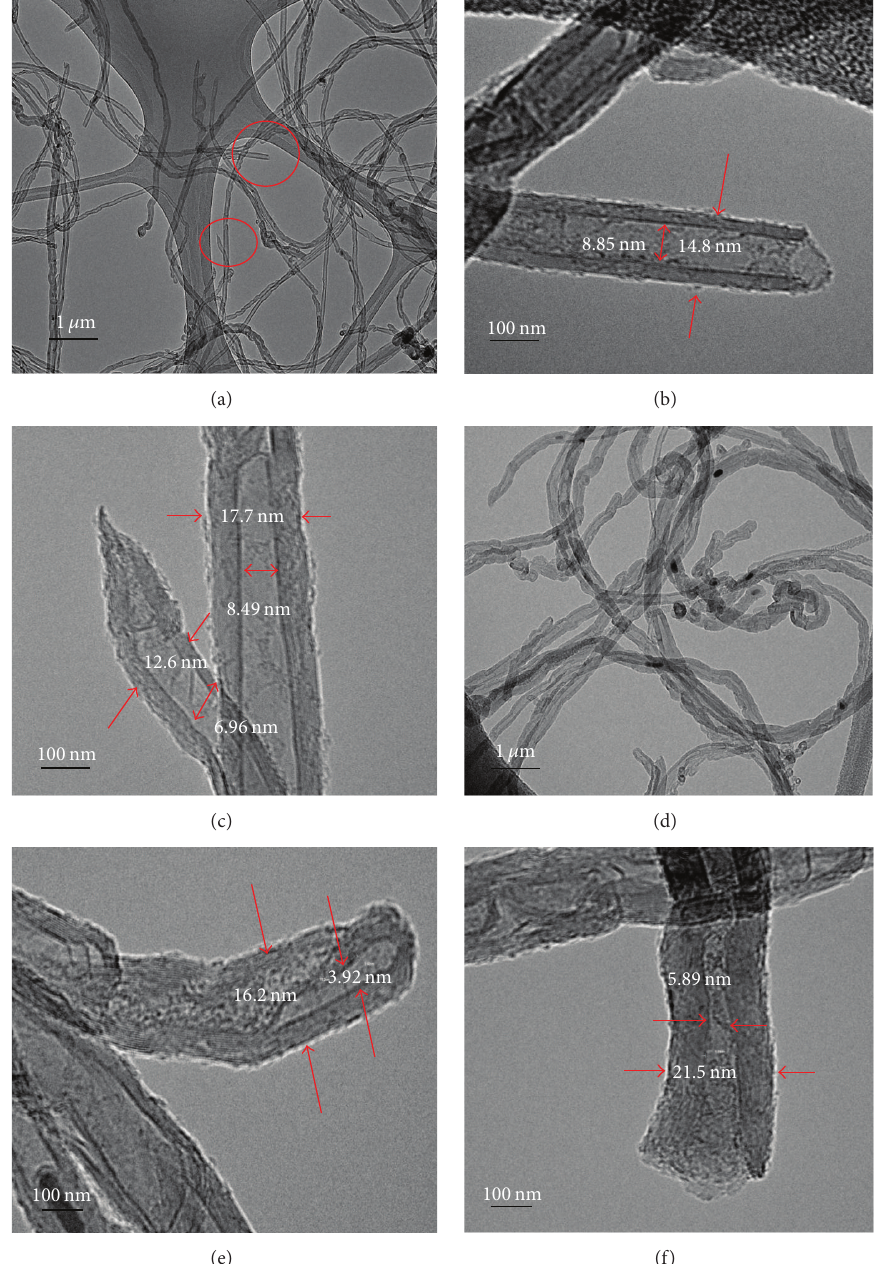
Figure 1: TEM micrographs of (a–c) functionalized multiwall carbon nanotubes and (d–f) urea grafted multiwall carbon